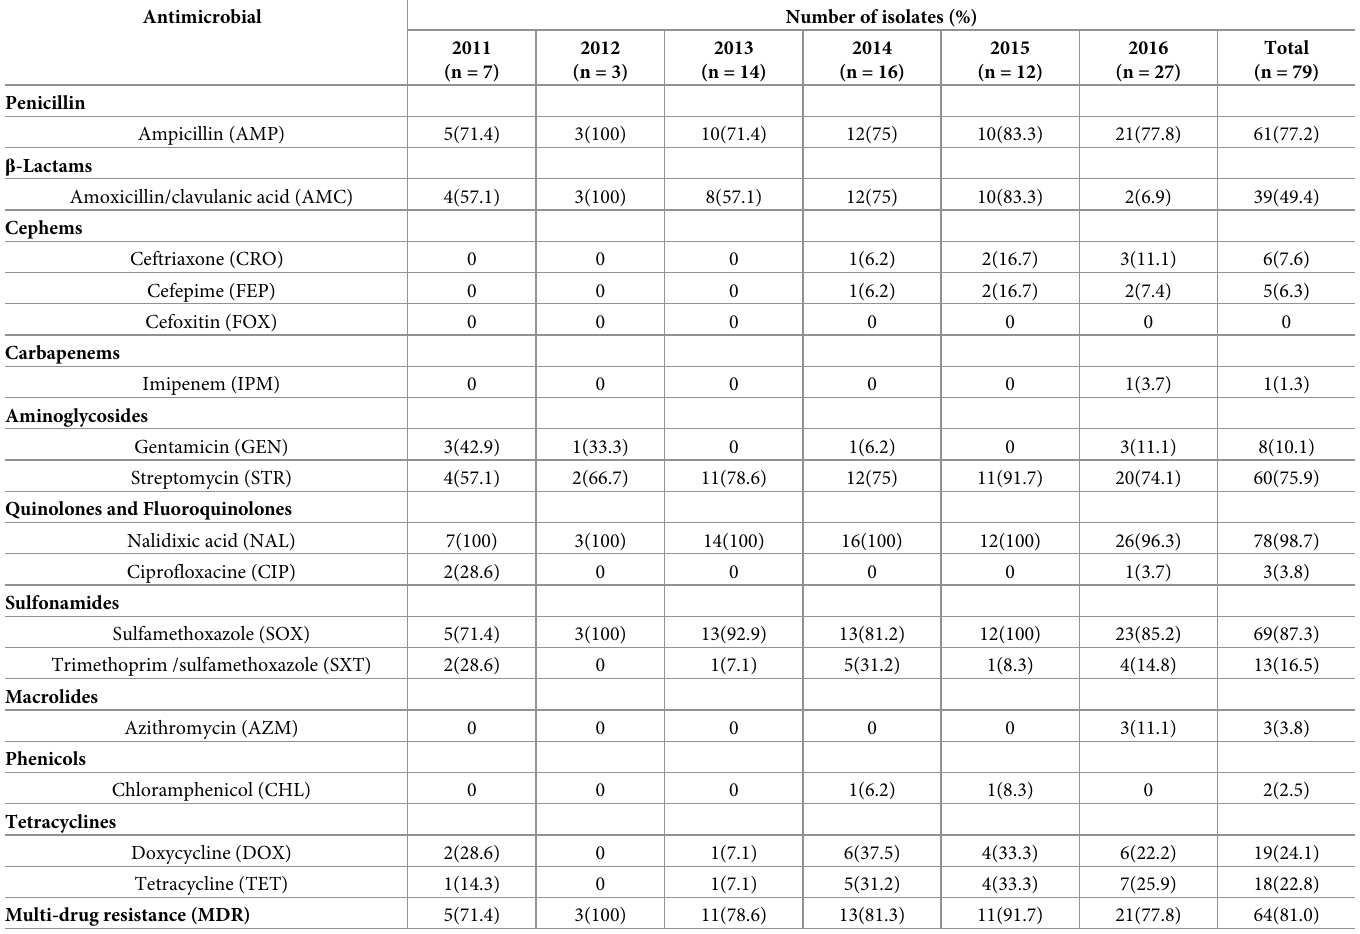
Table 1. Antimicrobial resistance of 79 S . Enteritidis clinical isolates in Guizhou from 2011 to 2016.